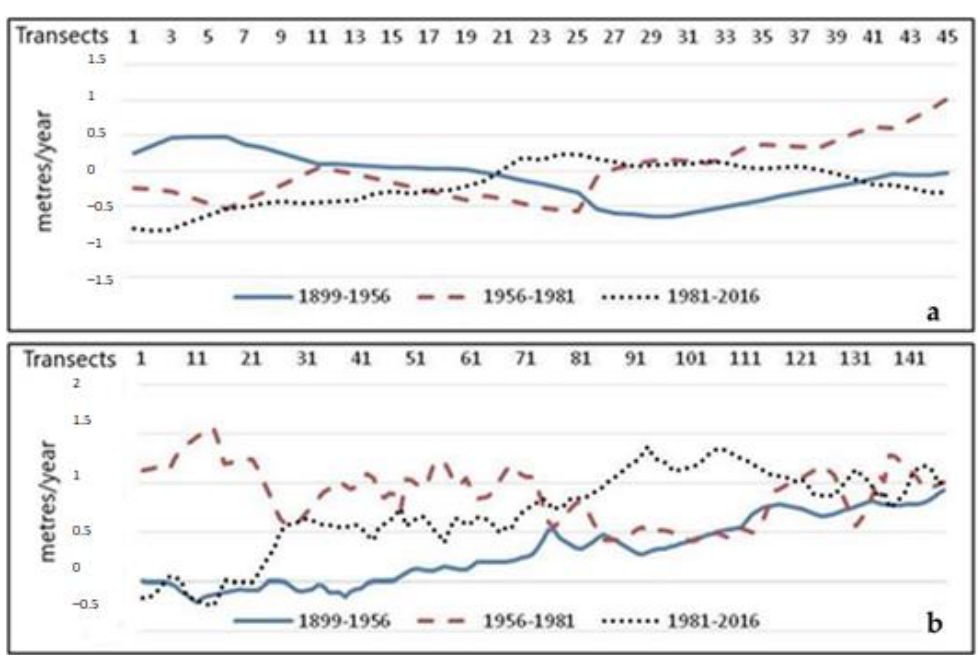
Figure 4. Shoreline variation rates evaluated along the transects in the beaches of El Mojón ( a ) and Torre Derribada ( b ).